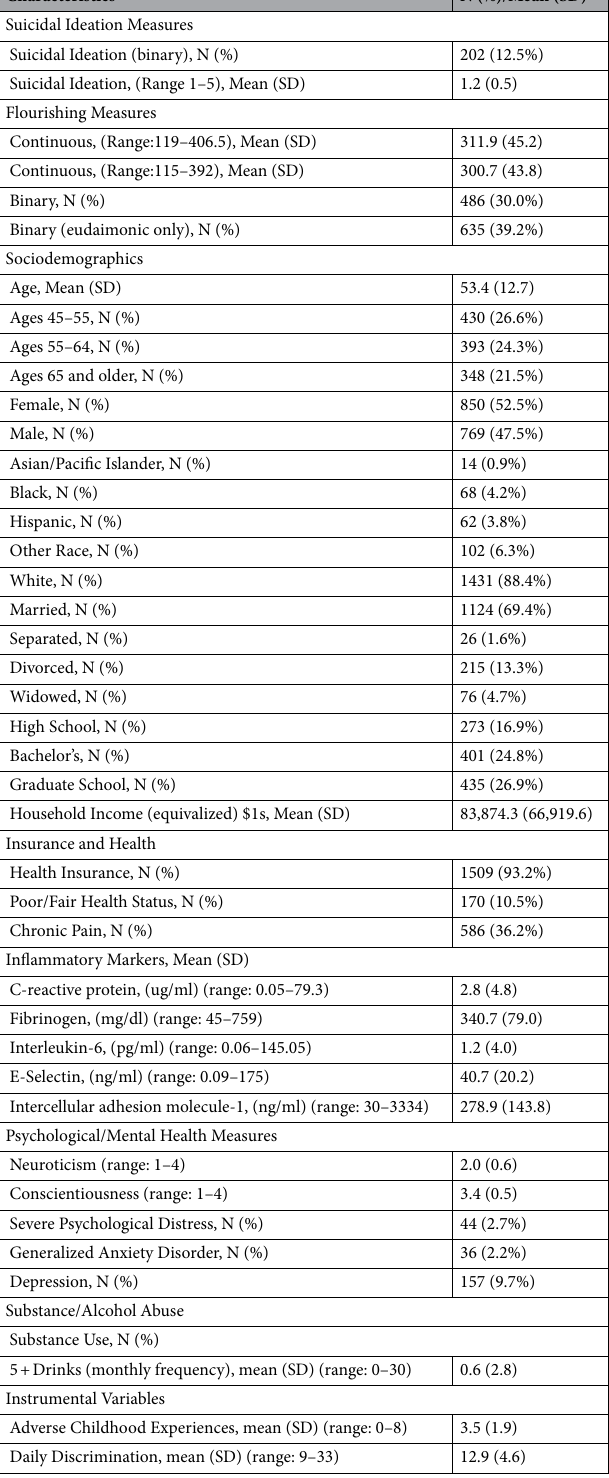
Table 2. Characteristics of the participants Included in the study sample (N = 1619) a . SD Standard Deviation. a Data were compiled from the MIDUS 2, MIDUS Refresher, MIDUS Refresher Biomarker Project, and MIDUS 2 Biomarker